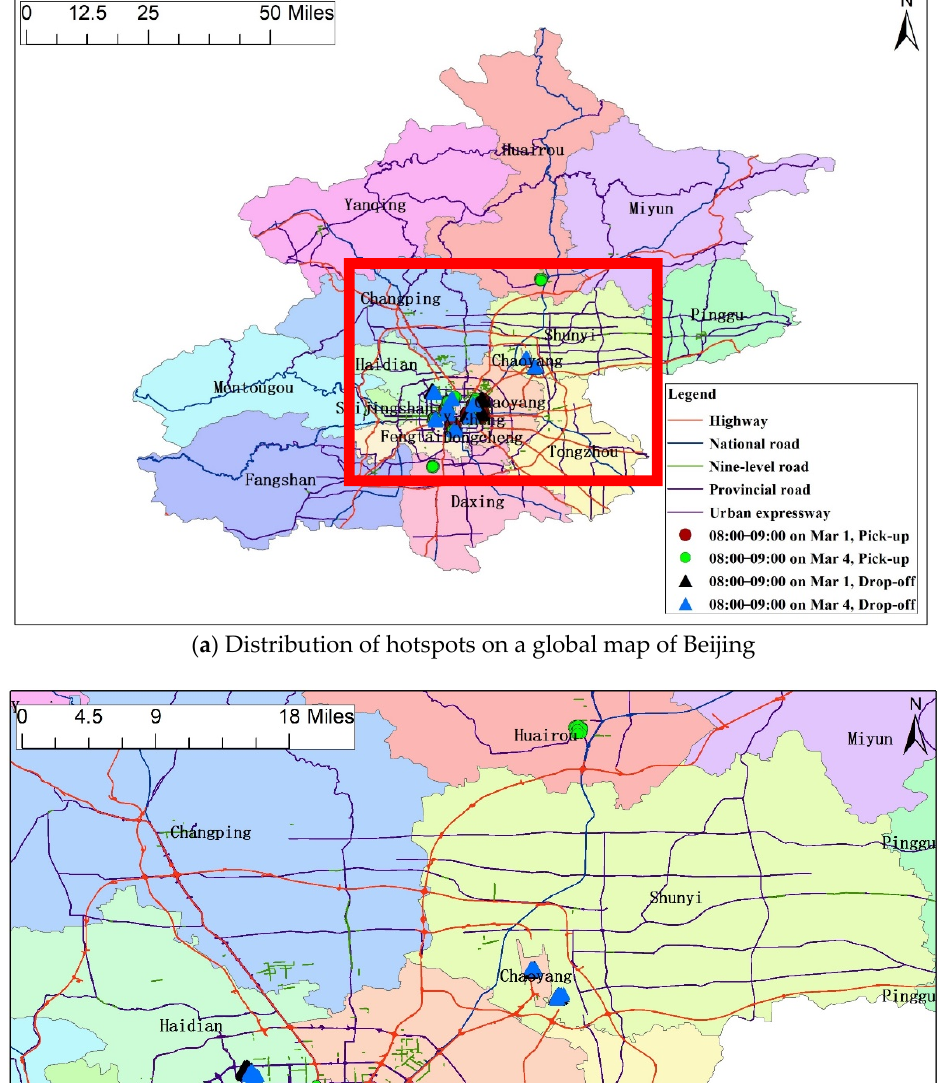
8:00 and 9:00, marked with symbols of four different colors and shapes. Figure 6a shows the distribution of hotspots on a global map of Beijing, and Figure 6b is an enlarged view of the area framed by the red box in Figure 6a. It can be seen that some high-density were areas that were both hot pick-up locations and hot drop-off locations, such as the areas hotspot areas are marked with different symbols, indicating that these areas are hotspots located at the exits of the Beijing Railway Station subway station, as shown in Figure 7. during this time period on the two days.